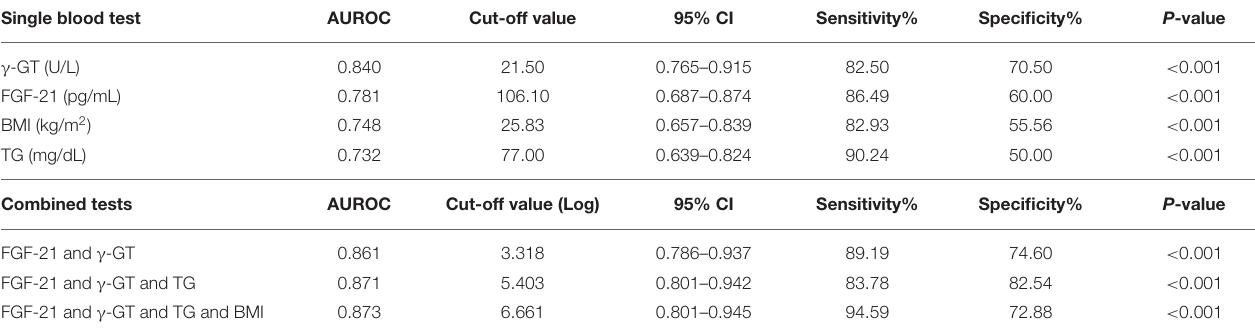
TABLE 3 | Summary receiver’s operating characteristic (ROC) of variables in the prediction of high-grade liver steatosis in the obese and overweight subjects. Single blood